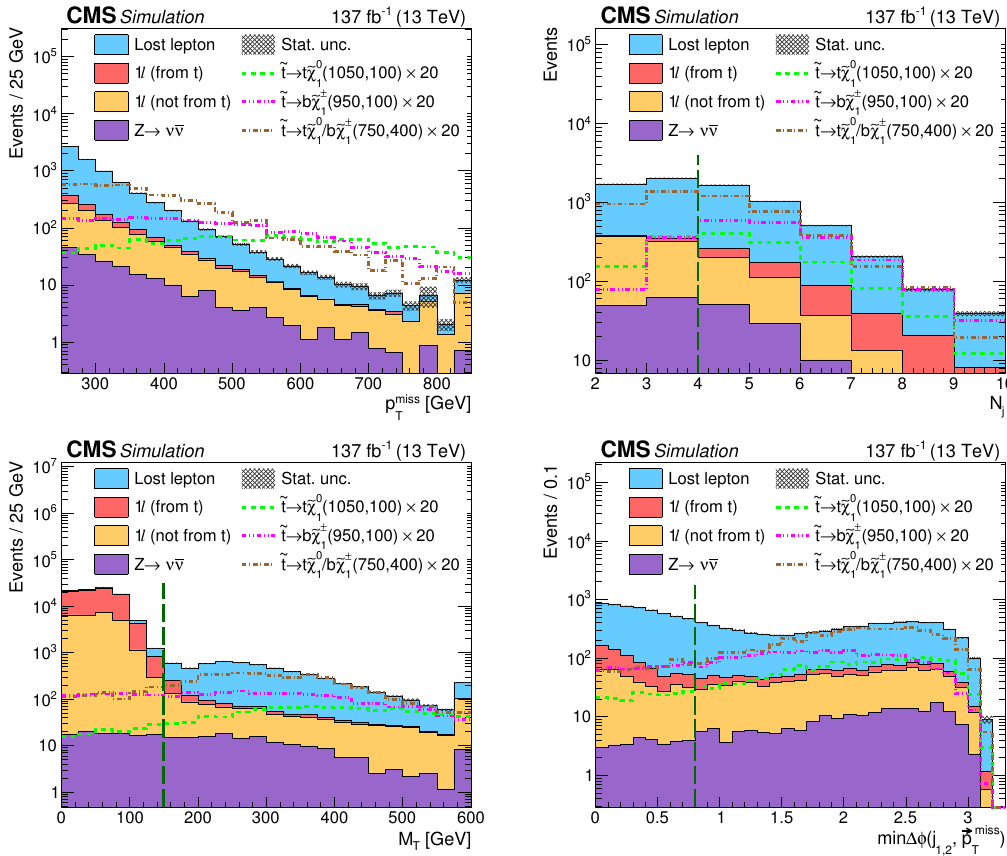
Figure 2 . The distributions of p miss (upper left) and N (upper right) are shown after applying T j the preselection requirements of table 1, including the requirement on the variable shown, and the distributions of M (lower left) and min (cid:1) (cid:30) ( j ; ~p miss ) (lower right) are shown after applying the T 1 ; 2 T preselection requirements, excluding the requirement on the variable shown with the green, dashed vertical line marking the location of the requirement. The stacked histograms for the SM back- ground contributions (categorized as described in section 5) are from the simulation to illustrate the discriminating power of these variables. The gray hashed region indicates the statistical uncer- tainty of the simulated samples. The last bin in each distribution includes the over(cid:13)ow events. The expectations for three signal hypotheses are overlaid, and the corresponding numbers in parentheses in the legends refer to the masses of the top squark and neutralino, respectively. For models with (cid:31) (cid:6) b decays, the mass of the chargino is chosen to be ( m + m ) = 2. 0 1 e t 1 e (cid:31)